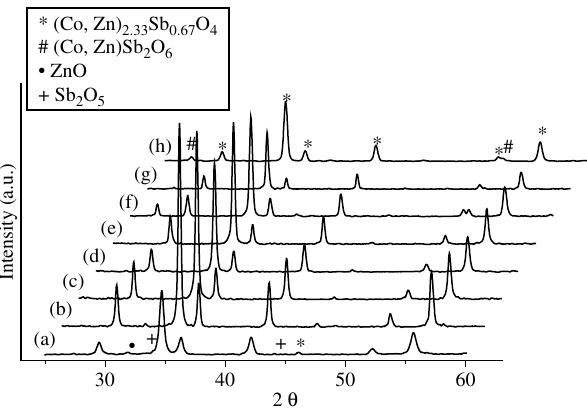
Figure 2. Decomposition peak temperature (DTG) as a function of cobalt amount.